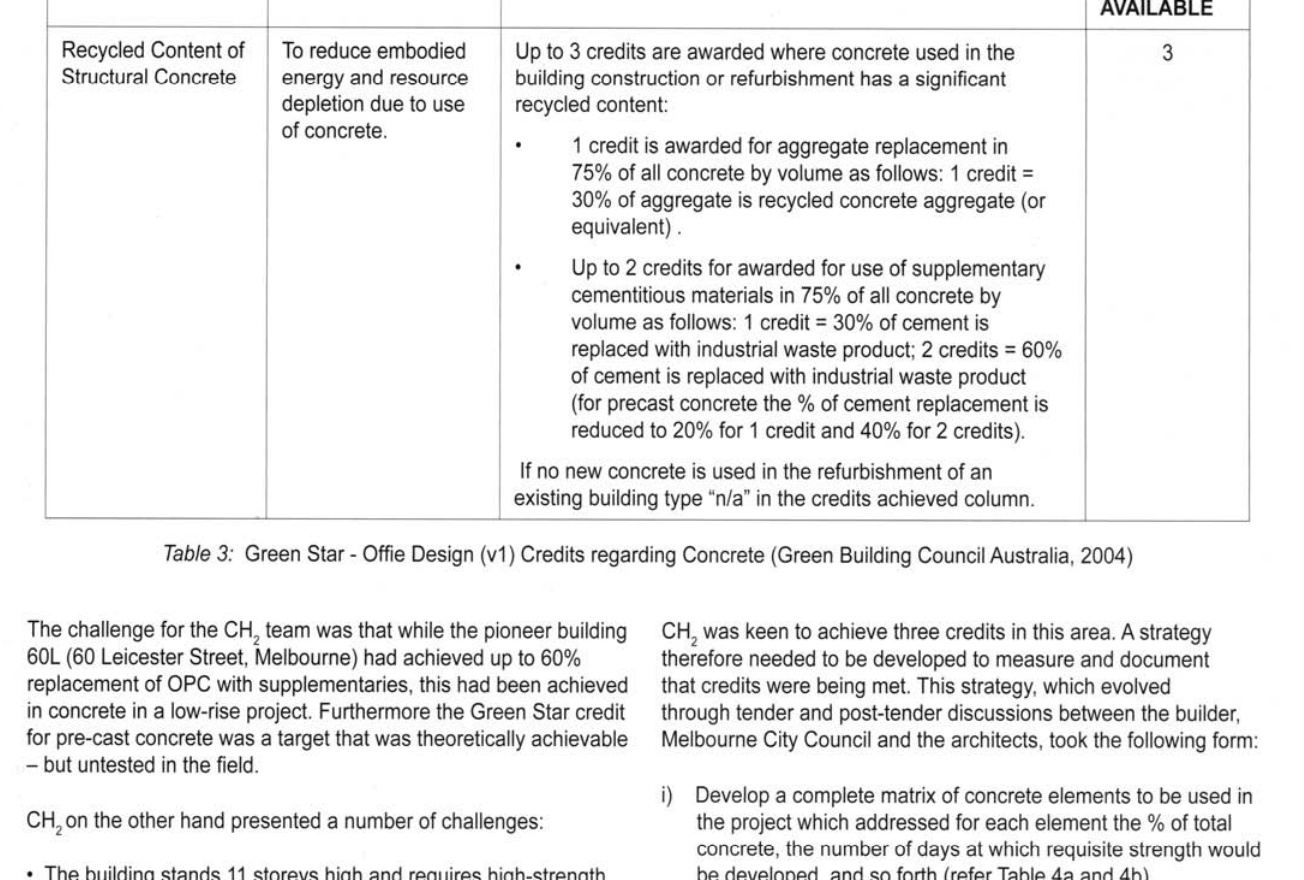
Table 4a: Summary of input to concrete matrix (for full version see www.ch2.com .au)